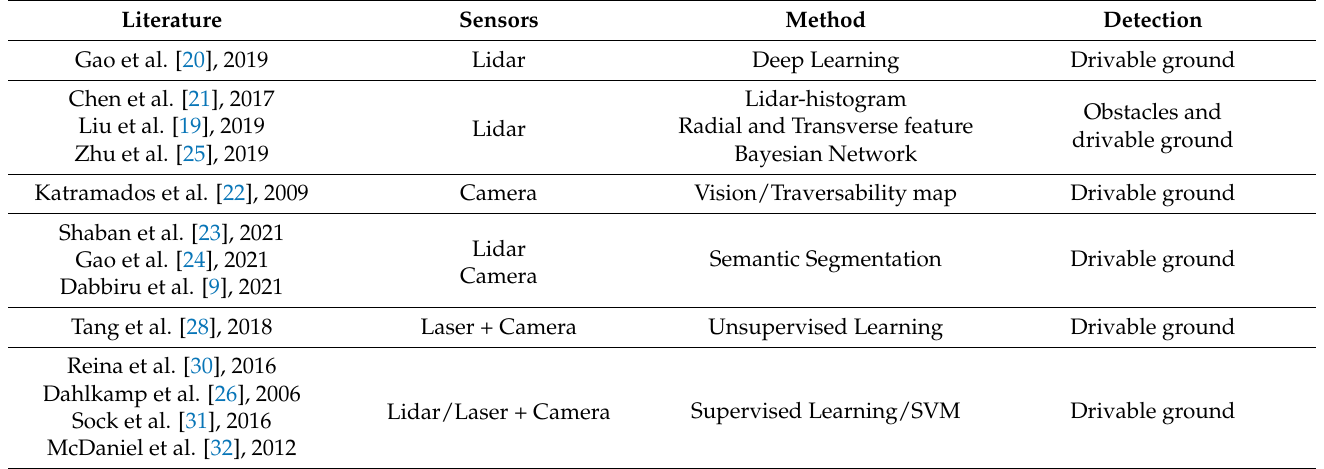
Table 2. The methods used for traversable ground